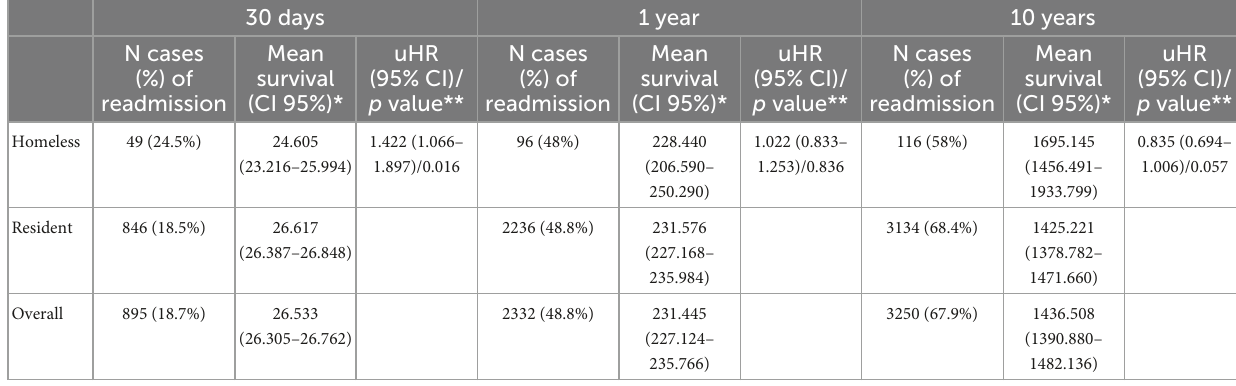
TABLE 2 Kaplan-Meier survival